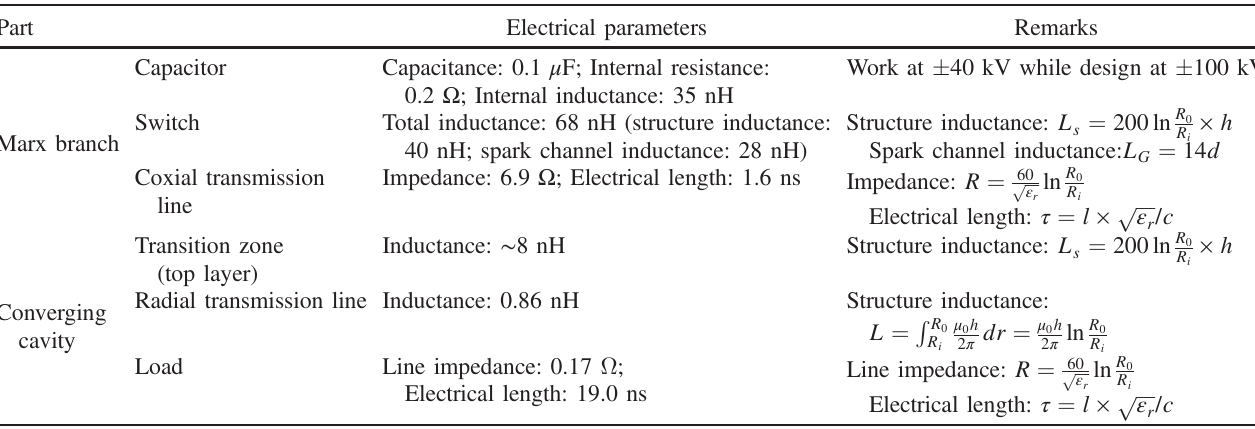
TABLE II. The relevant electrical parameters of each part.